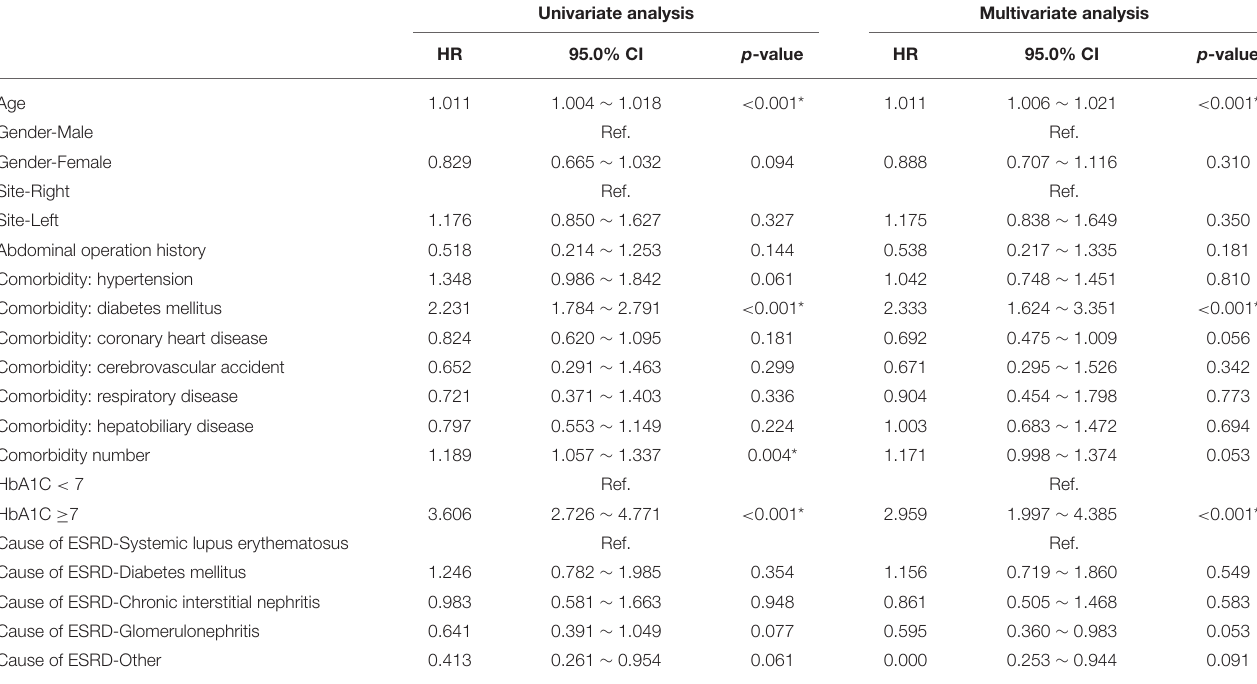
TABLE 2 | Proportional hazards model for PD catheter survival analysis.